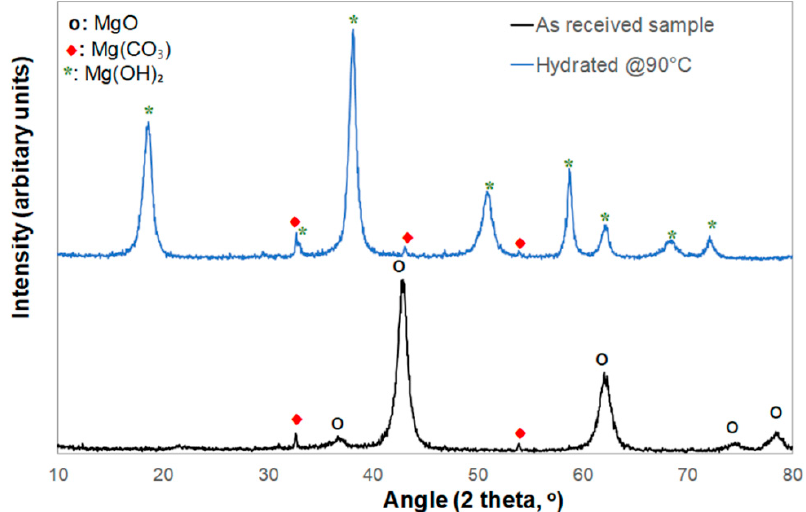
Figure 3. Comparative XRD spectra of the MgO PMP powder as received (black curve) and the Mg(OH) 2 powder recov- ered after hydration at 90 °C overnight in deionized water with a typical concentration of 0.04 gr. MgO per mL (blue